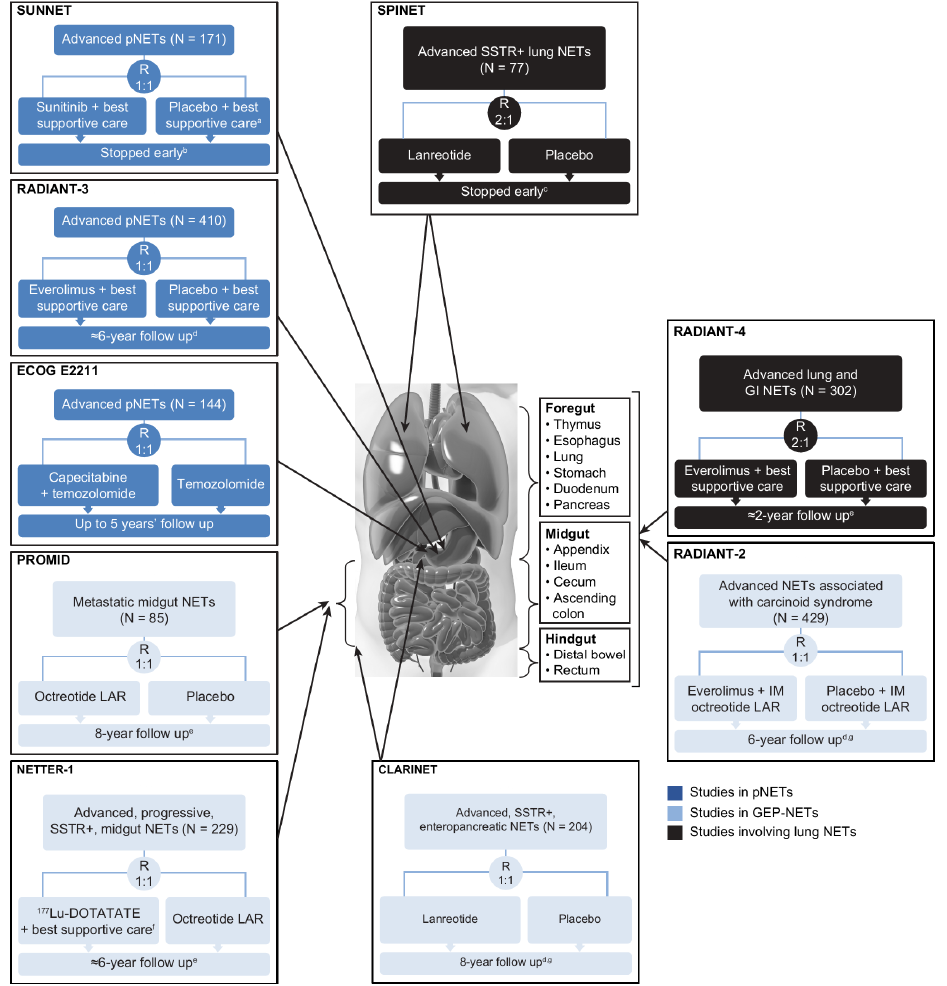
Figure 2. Randomized, controlled clinical trials conducted in the advanced NET setting. PROMID and CLARINET were the only trials involving primarily treatment-naïve populations; all other trials were beyond first-line therapy. a Patients could receive SSAs at the investigator’s discretion. b After the independent data and safety monitoring committee observed more serious adverse events and deaths in the placebo group as well as a difference in PFS favoring sunitinib. c Due to slow accrual. d Based on number of deaths. e Median. f Including IM octreotide LAR administered at a dose of 30 mg. g Including open-label extension phase. BID, twice daily; CLARINET, Controlled Study of Lanreotide Antiproliferative Response in Neuroendocrine Tumors; ECOG, Eastern Cooperative Oncology Group; GEP, gastroenteropancreatic; IM, intramuscular; LAR, long-acting repeatable; NETs,